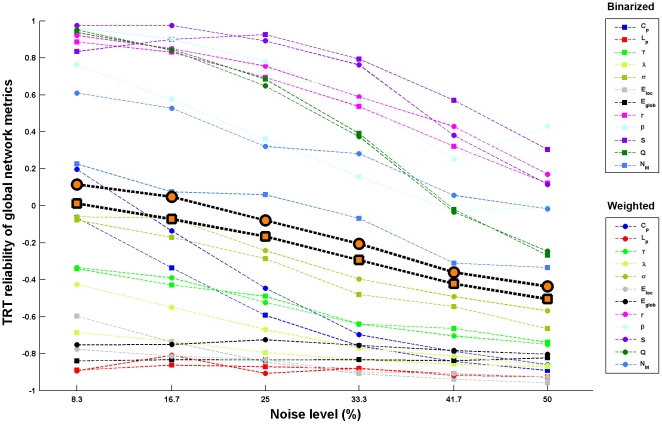
TRT reliability of global network metrics as a function of noise in RSFC for S-AAL-based networks.Global network metrics were sensitive to disturbances of RSFC and weighted network analysis generated numerically more stable results in comparison with binarized network analysis. The highlighted black border marks are the average reliability across metrics for binarized (square) and weighted (circle) network analysis, respectively. Of note, the sensitivity varied dramatically among metrics. Small-world parameters and network efficiency were extremely sensitive to even little noise in functional connectivity while assortativity, hierarchy, synchronization and modularity were relatively resistant to noise. TRT, test-retest; RSFC, resting-state functional connectivity.